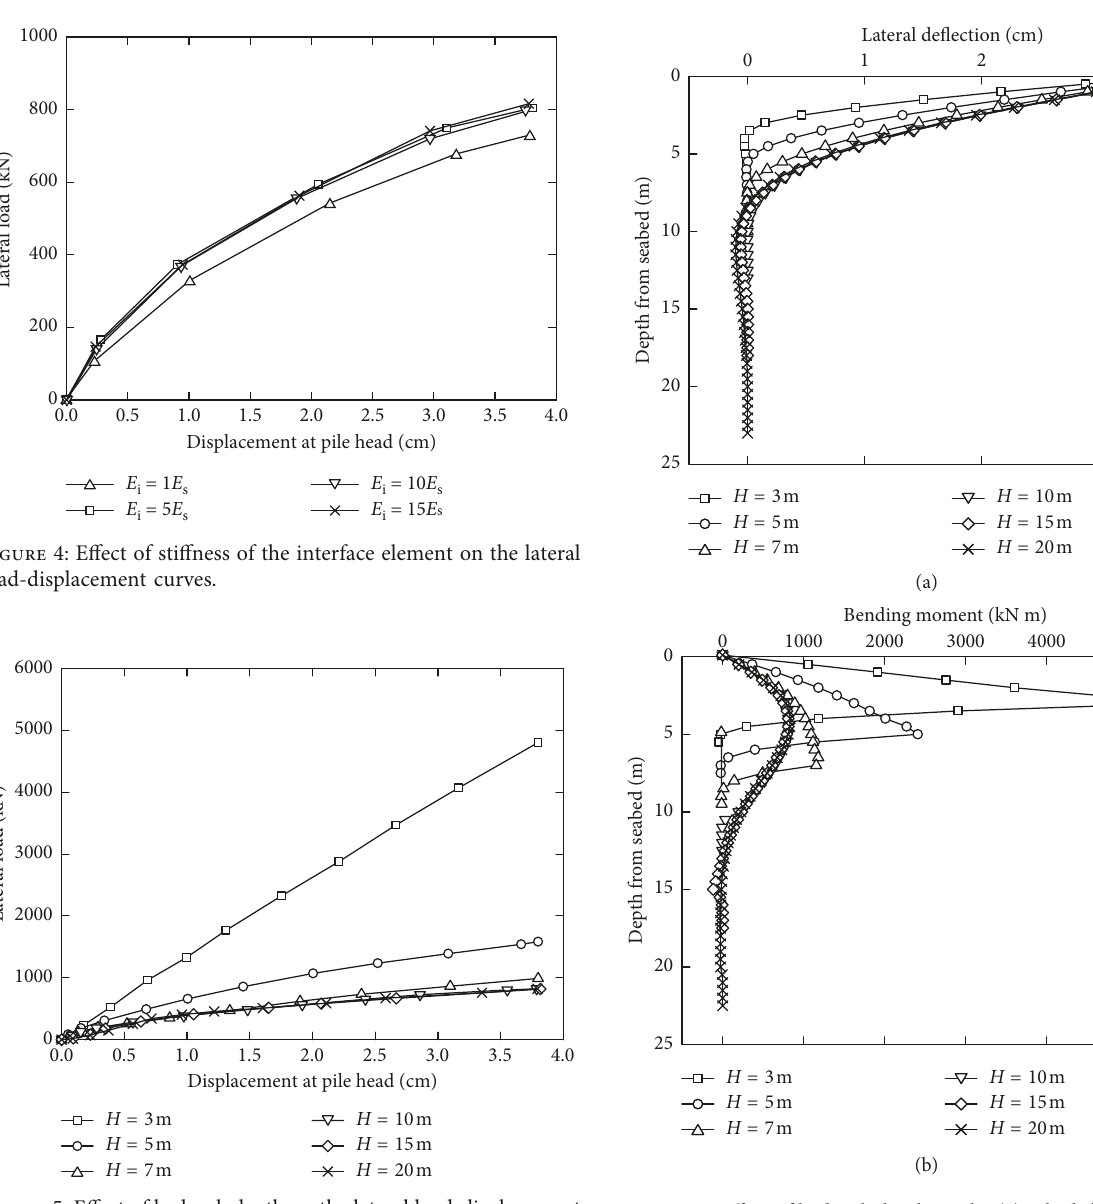
Figure 6: Effect of bedrock depth on the (a) pile deflection and (b) bending moment profiles.